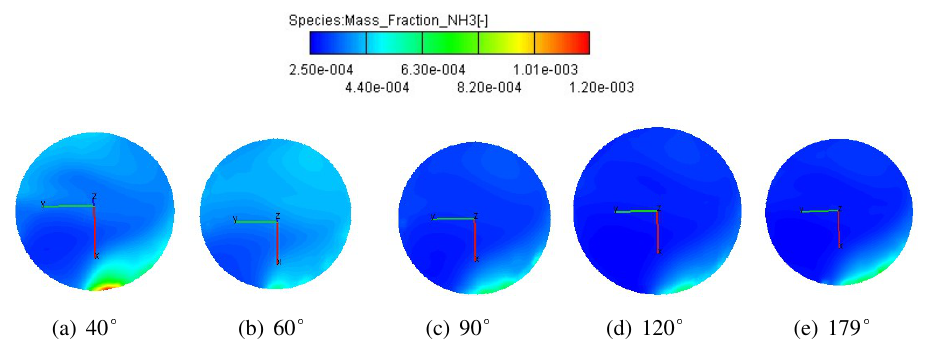
Fig. 8 Mass-fraction of NH 3 in Inlet cross section of carrier at different injection